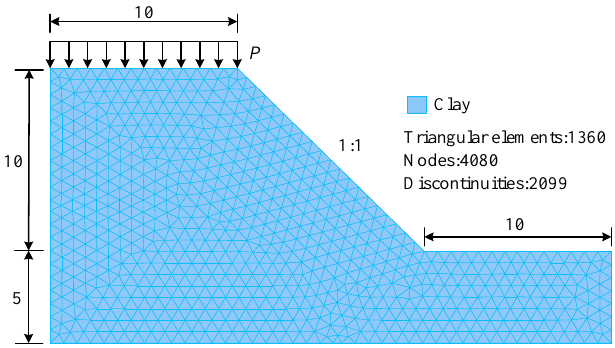
Figure 2. Homogeneous slope calculation model. Table 1. Calculation parameters of the